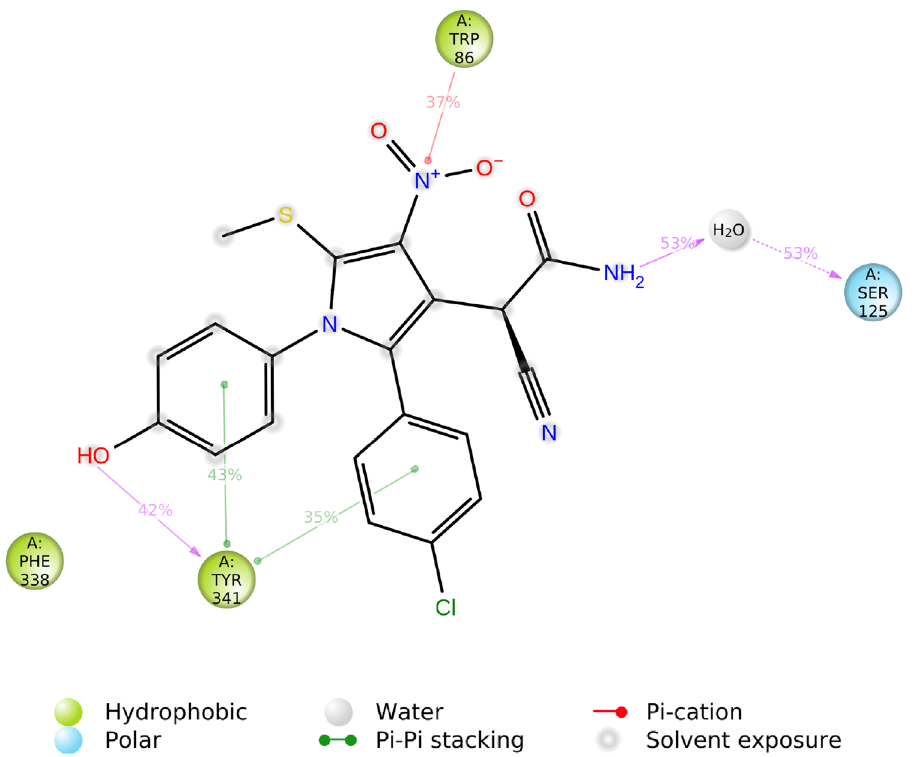
Figure 14. A schematic of detailed ligand atom interactions with the protein